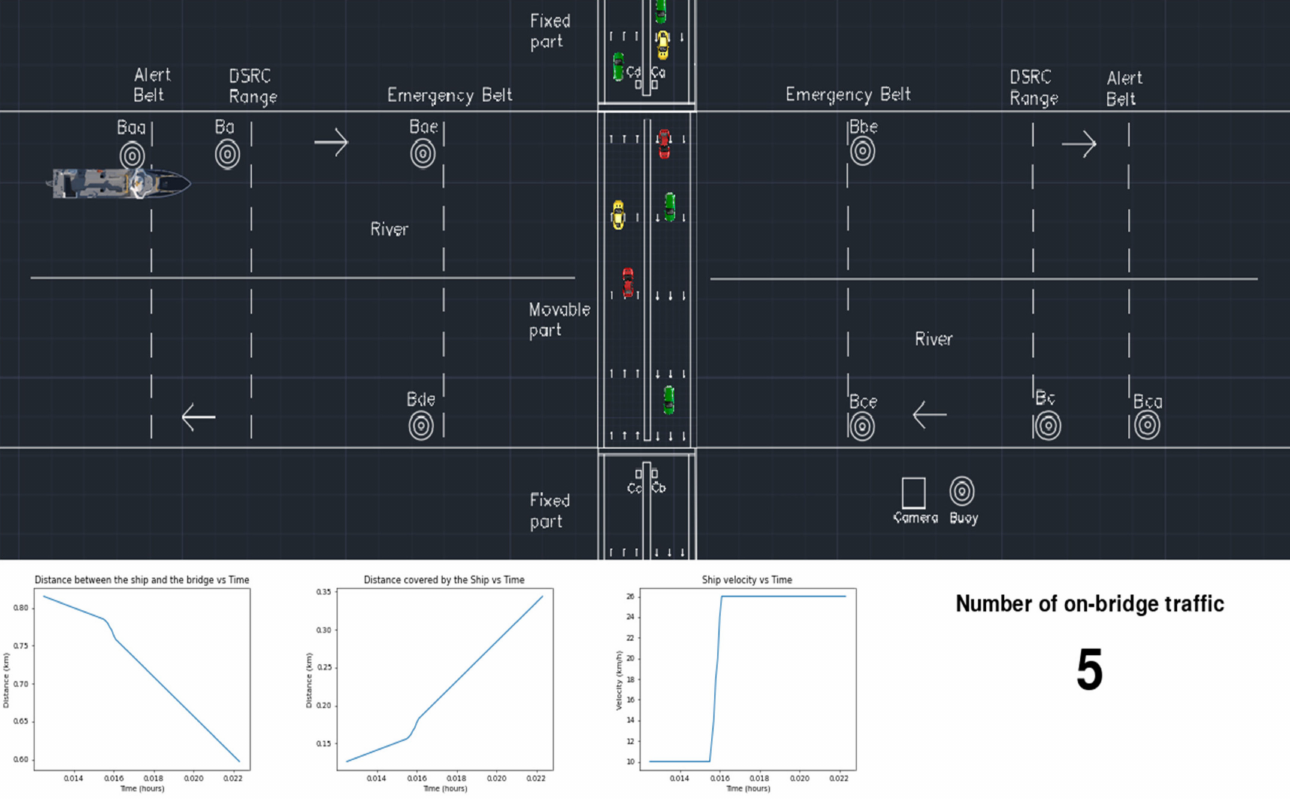
Figure 8. Ship sensing at the Alert